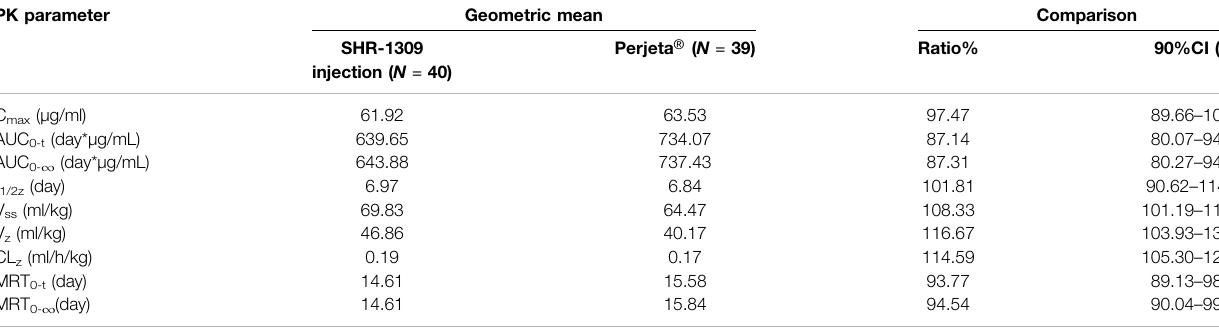
TABLE 3 | Results of the equivalence determination of the test drug and reference drug. PK parameter Geometric mean Comparison SHR-1309 injection ( N =